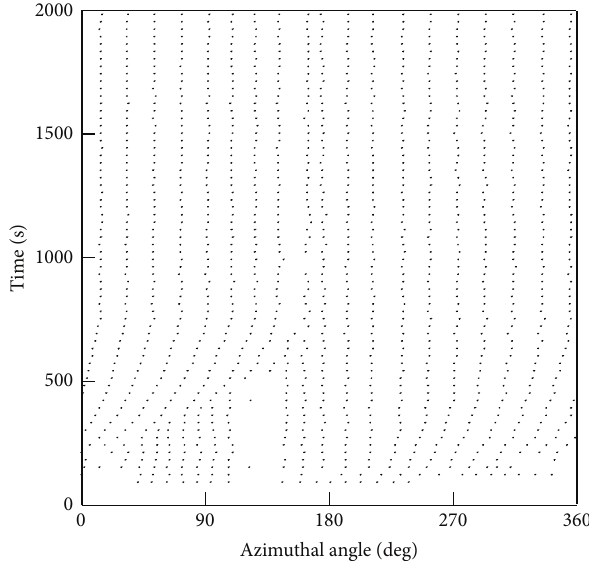
Figure7:Spatiotemporalevolutionofripples: 𝑞 = 0.216 , ] = 1.4 cSt, 𝑚 = 250 g, and Ω = 35.6 s −1 ; dots illustrate the positions of troughs between ripples. Azimuthal angle decreases in the direction of the cylinder rotation.